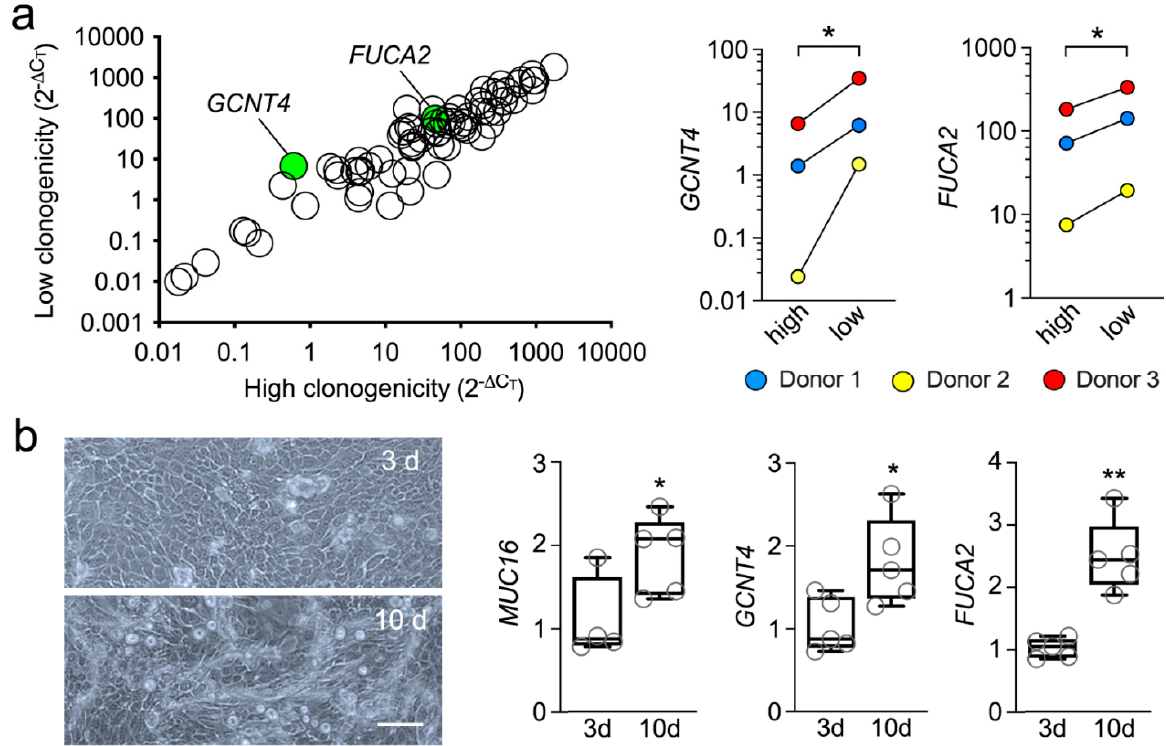
Figure 2. Abortive clones contain high levels of GCNT4 and FUCA2 . ( a ) Scatterplot comparing the expression of glycogenes in cells with different clonogenic potential (n = 3 independent donors). The green dots indicate statistically significant upregulation of the glycogene. The corresponding quantitative graphs are shown to the right. ( b ) Microscopic appearance of primary human limbal epithelial cells cultured at confluency for 3 or 10 days without supporting fibroblasts. By qPCR, MUC16 , GCNT4 and FUCA2 mRNA were significantly upregulated after culture for 10 days (n = 4–5 independent experiments). The data in ( a ) are presented as individual paired values. The box-and-whisker plots in ( b ) show the 25 and 75 percentiles (boxes), the median, and the minimum and maximum data values (whiskers). Significance in ( a ) was determined using a multiple paired t-test and in ( b ) using the unpaired t-test or Mann–Whitney test for nonparametric data. Scale bar: 100 µm. *, p < 0.05; **, p < 0.01.